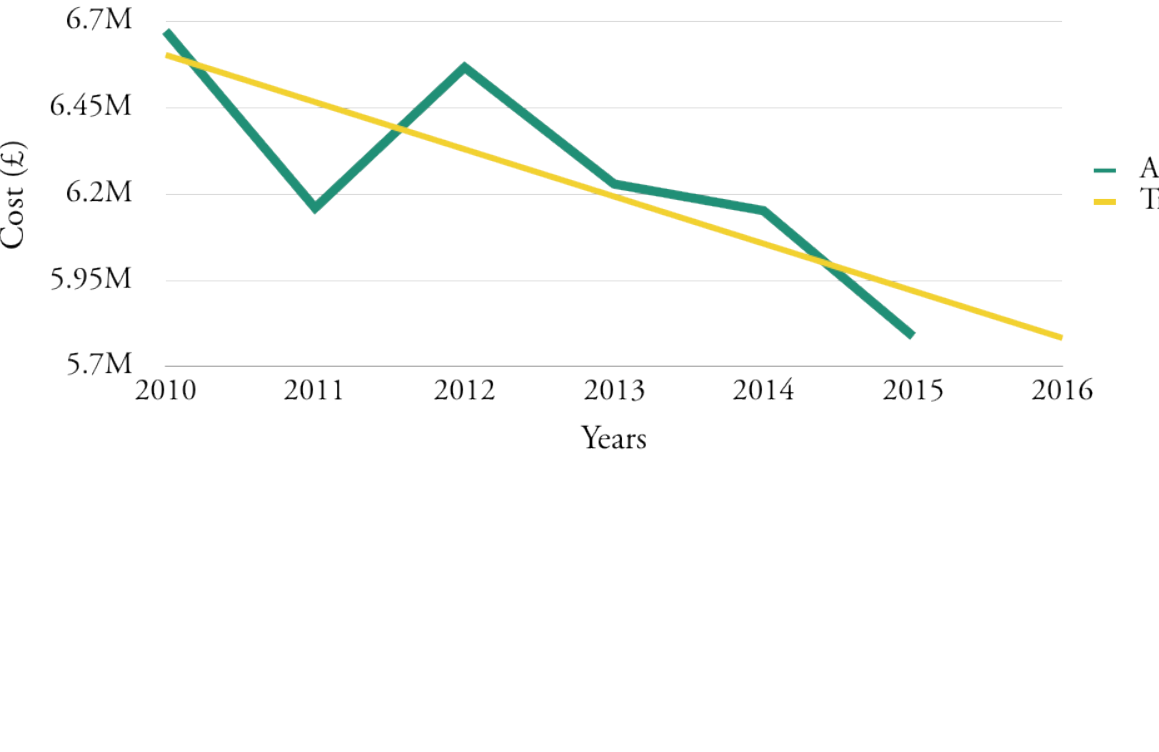
Table 7: OAEHSGCO and HSSU65PL agreements for difference postcodes in Birmingham.